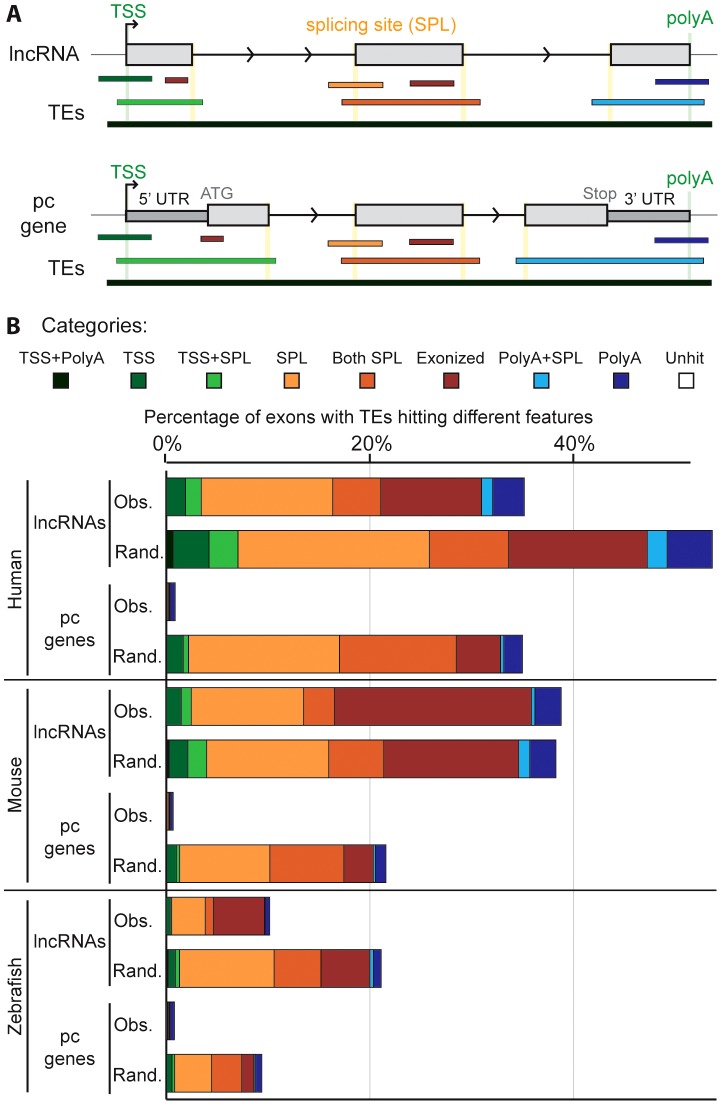
Contribution of TEs to different gene features of lncRNAs.A. Schematic of the type of overlap between TE and lncRNA sequences. Upper panel shows an idealized lncRNA transcription unit, and lower panel shows a protein-coding gene (only genes with annotated 5′ and 3′UTRs were analyzed; see Methods). Exons (grey boxes) overlapping a TE are categorized based on the type of overlap: the TE may provide functional feature(s), as a transcription start site (TSS), the first exon (including TSS and splicing site: TSS+SPL), a splicing site (SPL), a middle exon (including the 2 splicing sites (Both SPL), a polyadenylation site (polyA), the last exon (including splicing site and PolyA: PolyA+SPL). A TE not overlapping with any feature is called exonized. B. Comparison between observed (Obs) and random (Rand) distribution (see Methods). Note that a given exon can belong to several categories since a given TE can hit different exons and therefore be counted multiple times. Unhit exons correspond to exons with no TE overlap. Human: lncRNAs from Gencode v13. Mouse: lincRNAs from Ensembl release 70. With the exception of ‘exonized’, ‘TSS’ and ‘polyA’ categories in mouse (p-values = 1, 0.001 and 0.298 respectively) and ‘exonized’ category in zebrafish (p-value = 0.001), the p-values were systematically <0.0001.